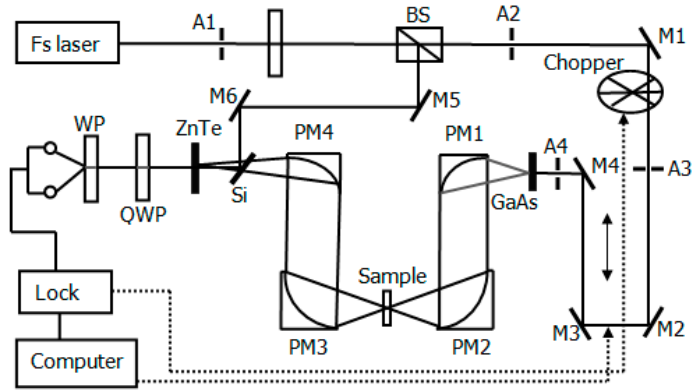
Figure 1. Schematic diagram of the THz-TDS spectrometer.